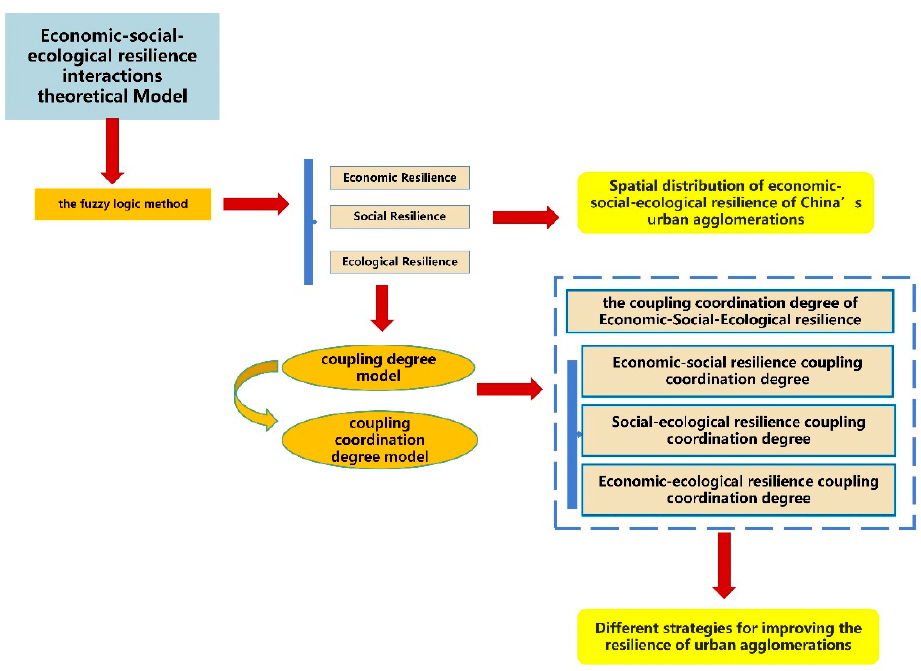
Figure 3. Logical framework of the study.